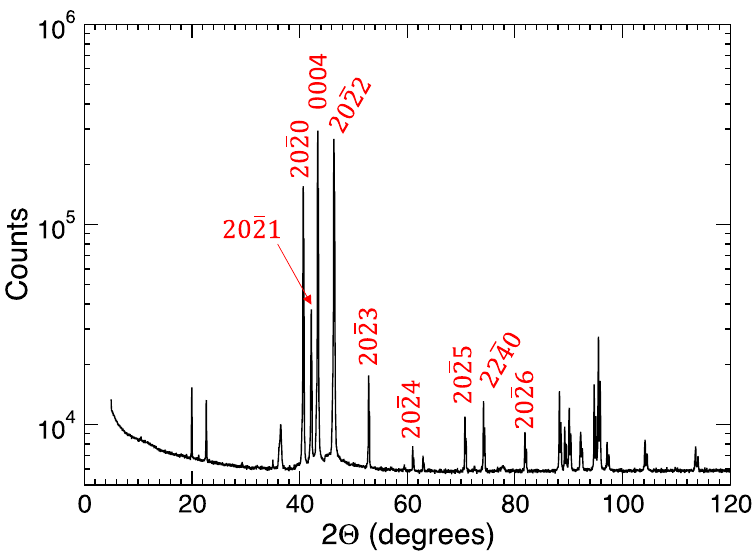
Figure 7. X-ray diffraction peaks of the of 79.24 wt.% Ni, 19.75 wt.% Ti, and 1.01 wt.% Al ingot suggesting the formation of the D0 24 Ni 3 Ti phase. No evidence of LRO on the Al/Ti sublattice.